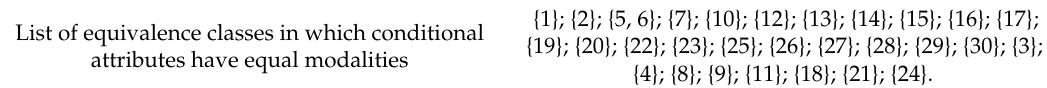
Table 4. Equivalence classes.